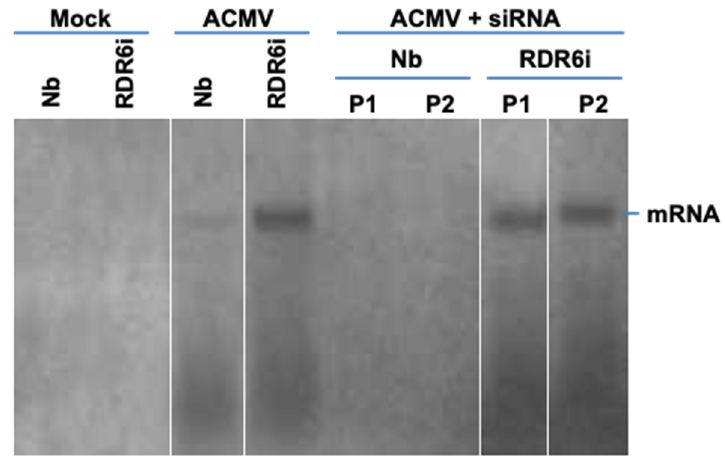
Figure 6. Northern blot detection of ACMV mRNA. RNA was extracted from leaf tissues of wild-type N. benthaniana (Nb) and transgenic NbRDR6i (RDR6i) line plants with mock inoculation and of plants inoculated with ACMV alone (ACMV), or together with hotspot ds-siRNA (ACMV + siRNA) at 14 days post-inoculation. Duplicate plants (P1 and P2) were sampled for detection. Viral mRNA was detected by probe A3 specific to DNA-A (Figure 2A). The position of viral mRNA is indicated. We would like to point out that this figure was re-assembled with different lanes separated by white lines from one same blot.